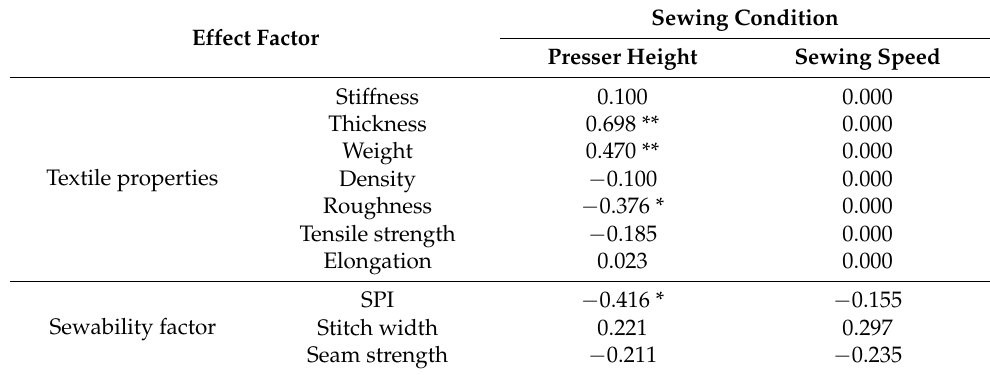
Table 12. Correlation coefficient between sewing conditions and textile properties or sewability in the zigzag stitch. Effect